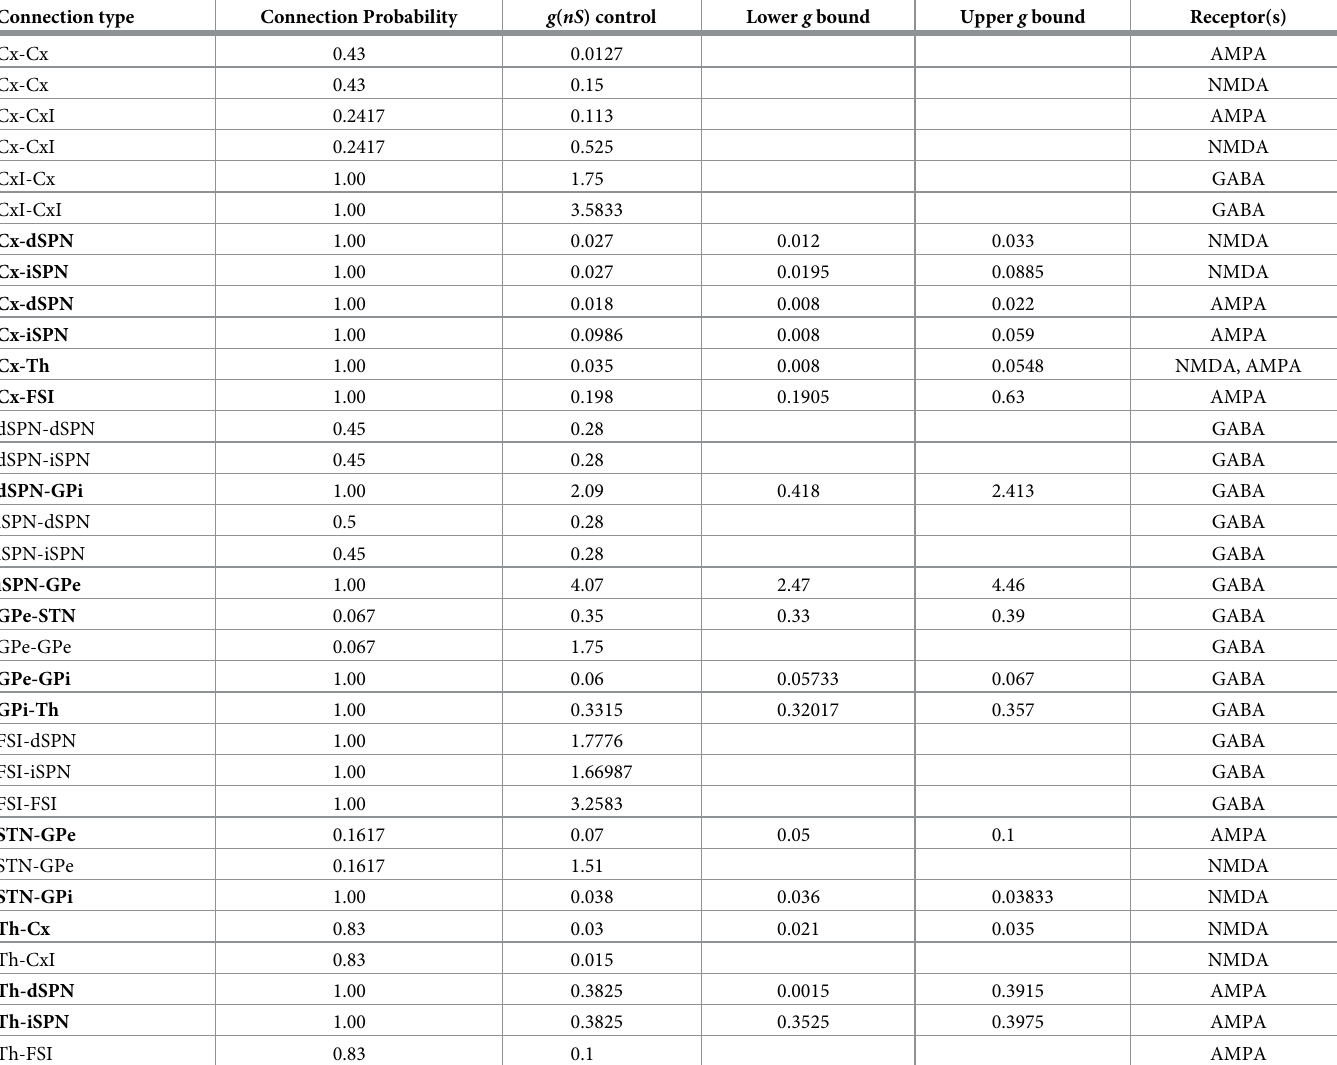
Table 3. CBGT connectivity. From left to right, the connections included, specified in terms of the pre- and the post-synaptic populations that they link; the probability that two cells in the pre- and post-synaptic populations will be synaptically linked; a fixed synaptic conductance or weight (measured in nS ) used in our control case; the lower and upper bounds on weights based on maintaining realistic neuronal firing rates; and finally the receptor types for each specific connection. Those connections that are not in bold font (i.e. without an upper and lower bound) are fixed to the control value during all simulations. The topology of each connection, which can be either dif- fuse (they project to left and right action channels) or focal (restricted connections within each channel), has not changed from [28](Table 3).